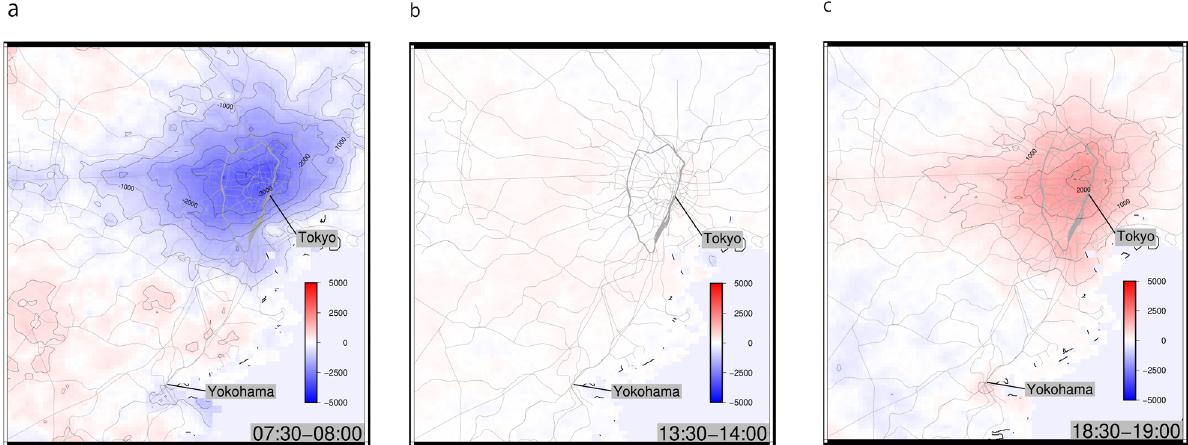
Figure 3. Temporal changes of electric potential ( a ) Morning, ( b ) Afternoon, ( c ) Evening. Blue and red represent valley-like and mountain-like shapes, respectively.